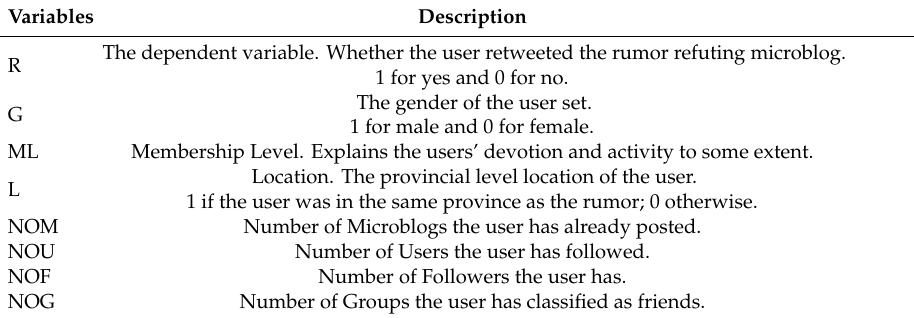
Table 2. Variables for the control